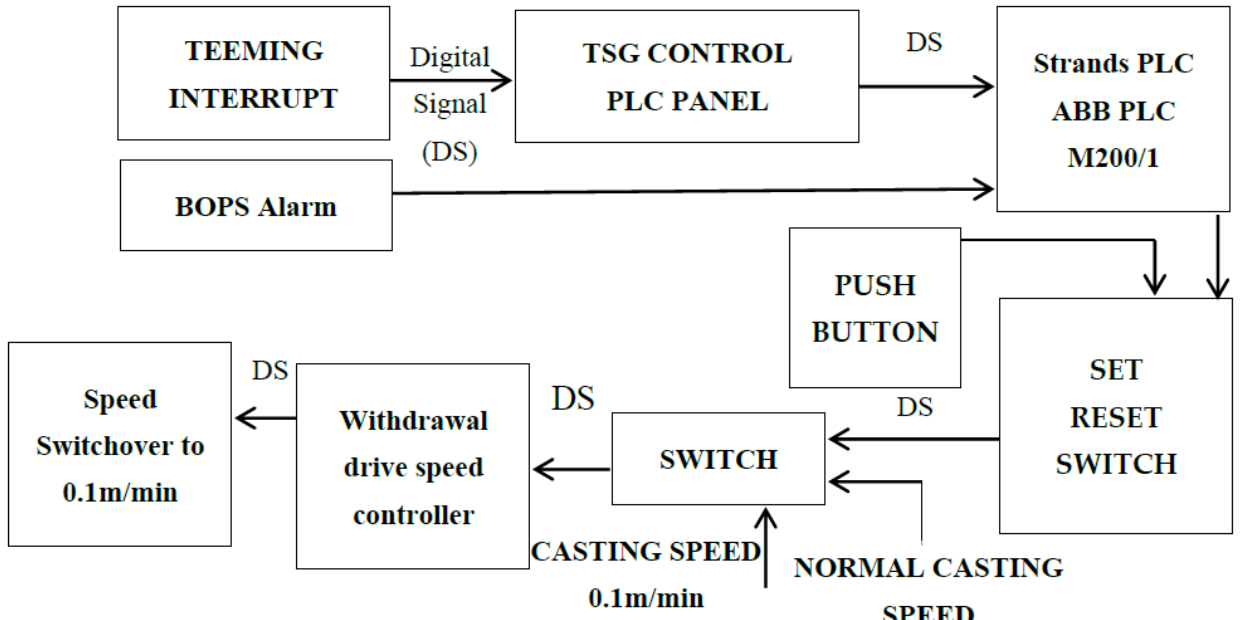
Figure 16. Proposed modem to reduce casting speed